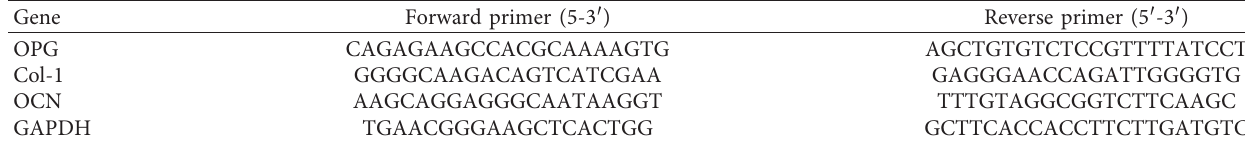
Table 1: Primers used for quantitative